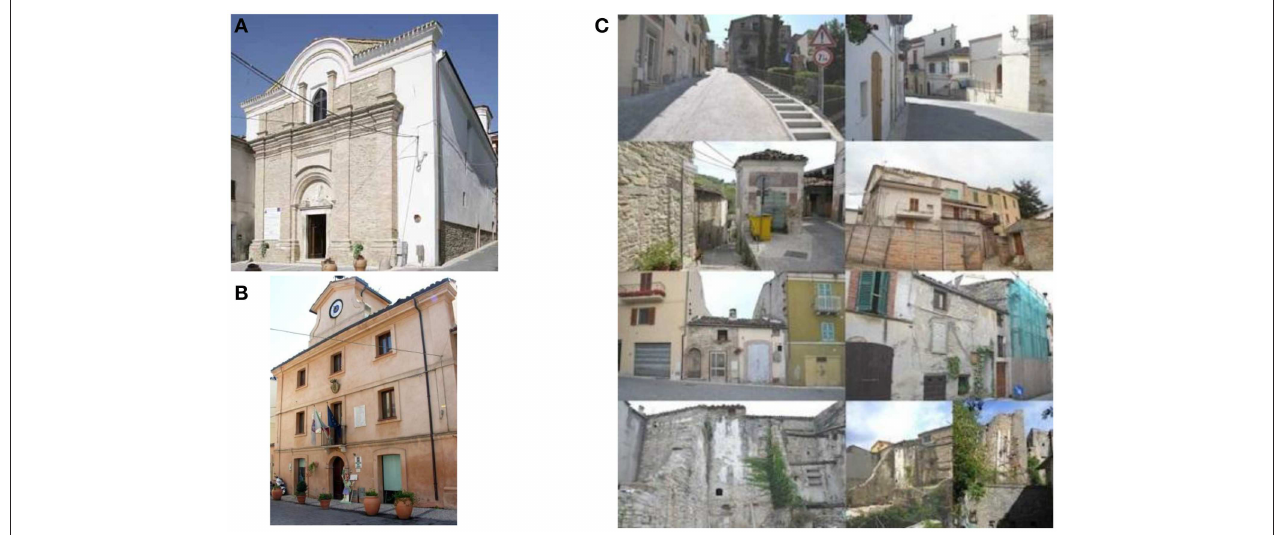
FIGURE 2 | Cultural and residential heritages of the historical center of Arsita: Santa Vittoria church (A) , Wolf Museum (B), and some clustered buildings (C) (source: personal